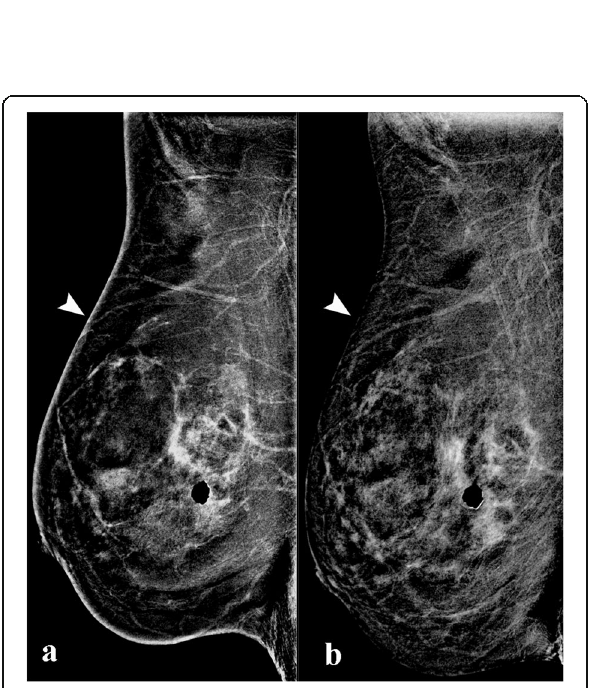
Fig. 13 Skin-line artefact. a The early-recombined image demonstrates a marked enhancement of the skin line. b The skin enhancement is not appreciated in the delayed recombined CEDM acquisition